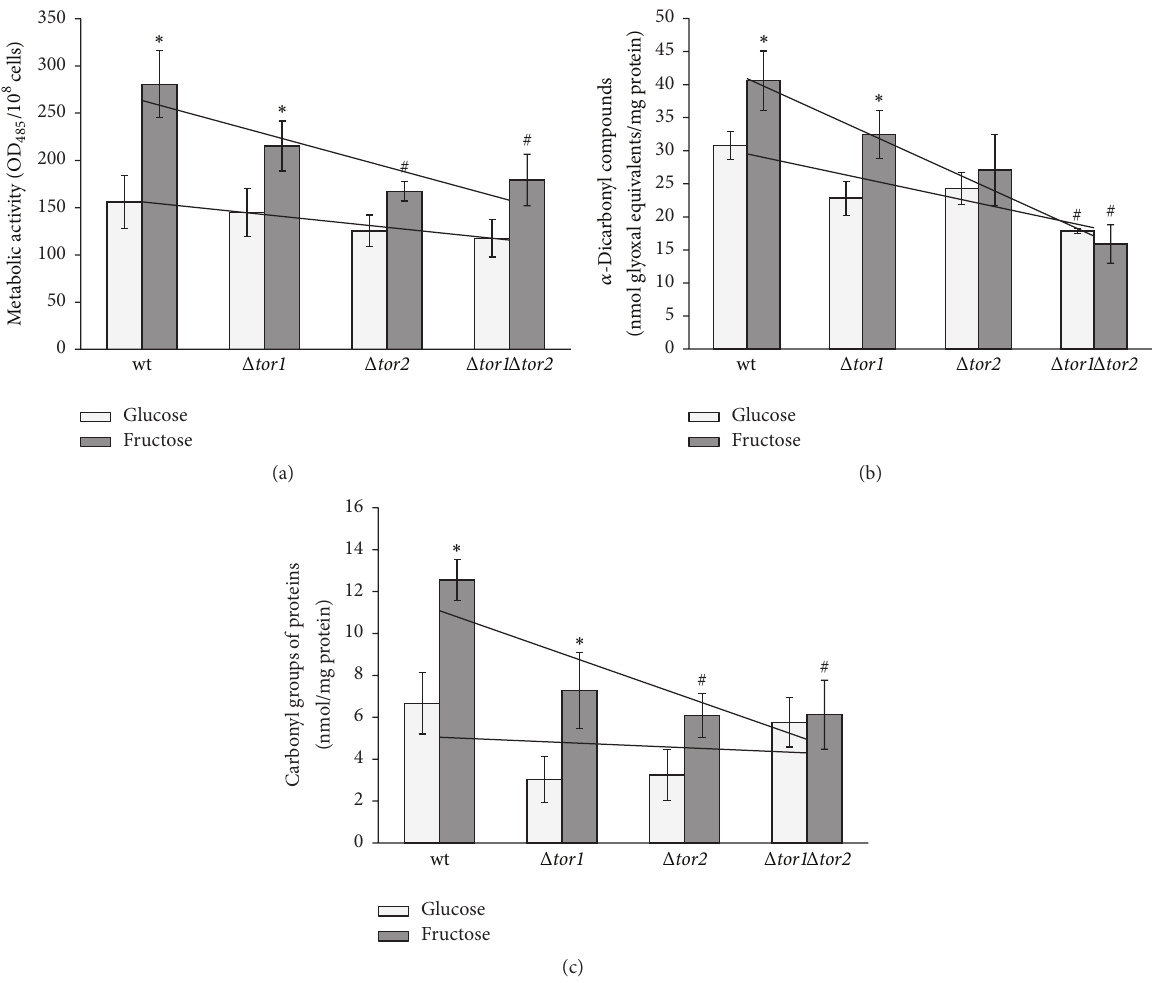
Figure 8: The metabolic rate (a) and level of carbonyl/oxidative stress markers: 𝛼 -dicarbonyl compounds (b) and protein carbonyls (c), in glucose- and fructose-grown S. cerevisiae JK9-3da and its mutants Δ tor1 , Δ tor2, and Δ tor1 Δ tor2 . Results are shown as the mean ± SEM ( 𝑛 = 3 – 6 ). ∗ Significantly different from respective values for glucose and # wild type with 𝑃 < 0.05 .